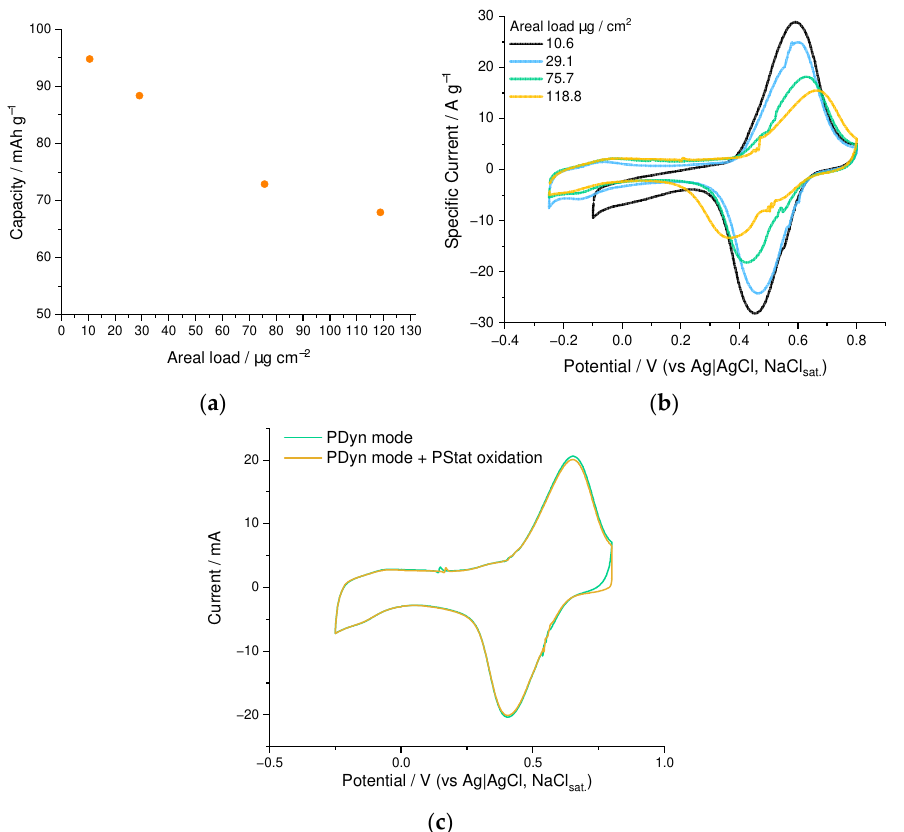
Figure 9. ( a ) gravimetric capacity vs. the areal loading and ( b ) CV curves of PEDOT:SPVC films deposited to different areal loadings; ( c ) CV of the PEDOT:SPVC film with and without potentiostatic oxidation at 0.8 V; 0.1 M HClO 4 /H 2 O, 20 mV·s −1 .